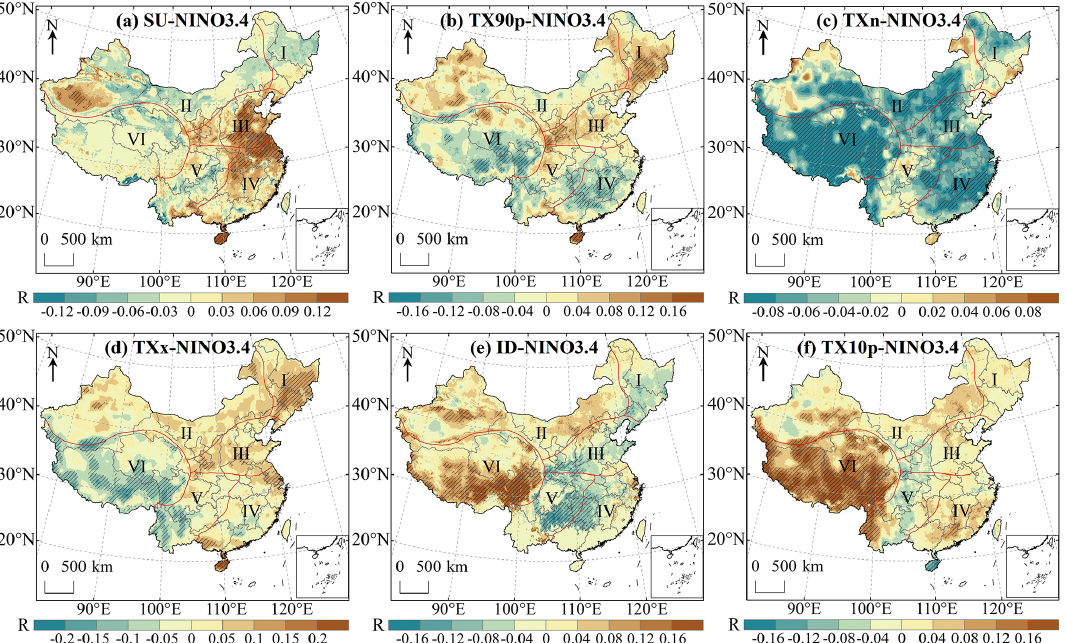
Figure 21. Correlation analysis between extreme temperature indices and NINO3.4 in China during 1979–2018. The shaded areas indicate correlations that are significant at the 0.05